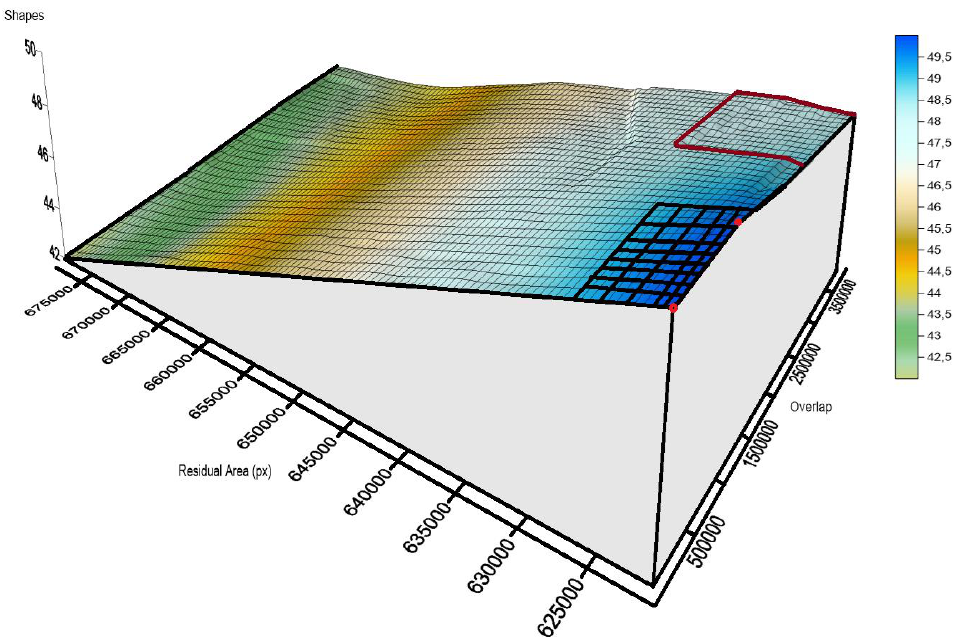
Figure 4. ILS landscape average of 500 tests (shapes, overlaps, and residual area).